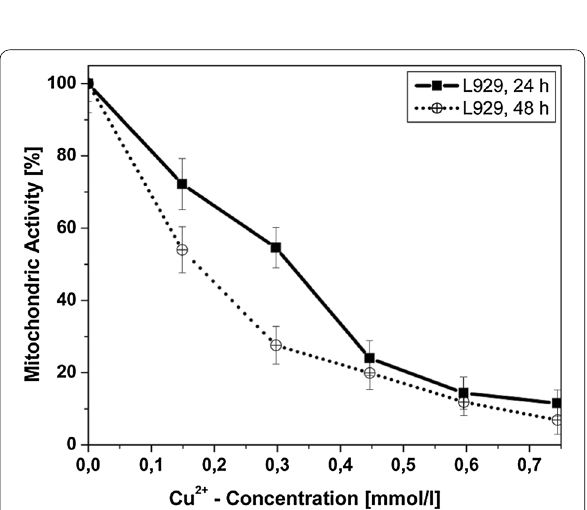
Fig. 3 Cell vitality of fibroblasts L929 in dependence of the Cu 2 + -concentration and the cultivation time in the culture medium